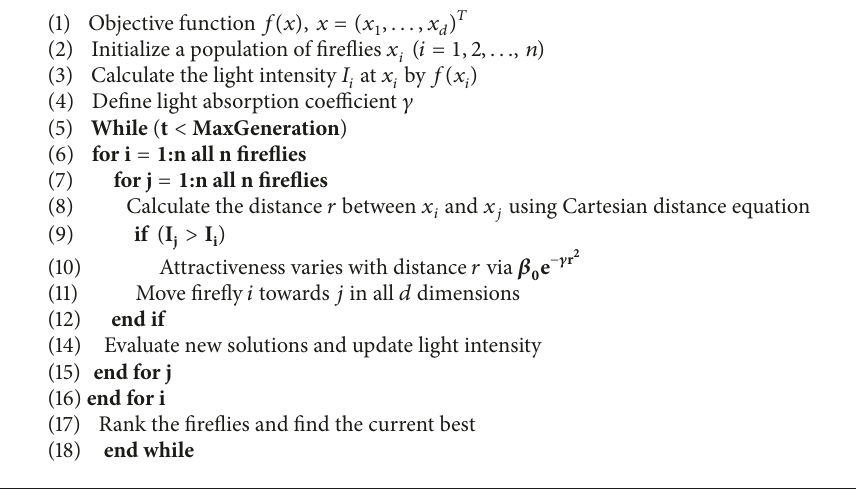
Algorithm 1: Pseudocode for firefly algorithm [11].